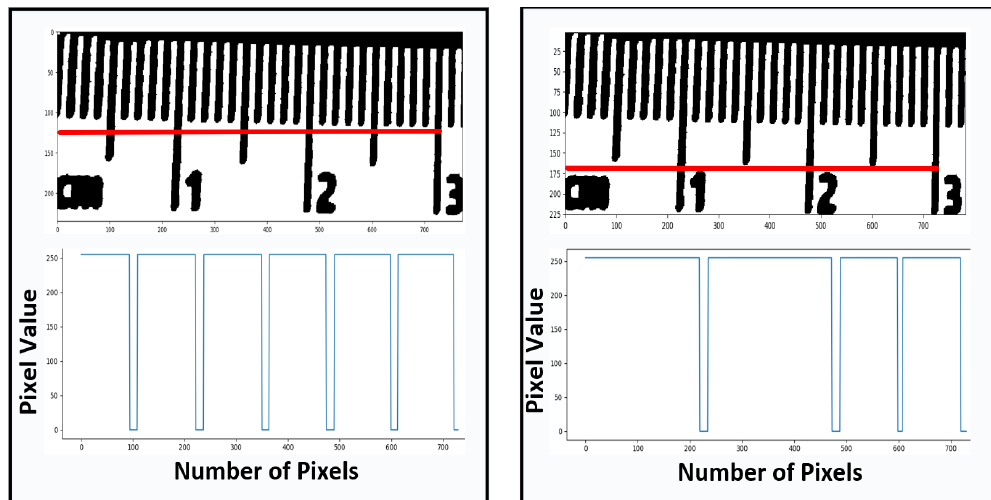
Figure 5. (Scale Search and Results) Left are the search lines. Right displays both the line and the distribution of 5 M f and 10 M f